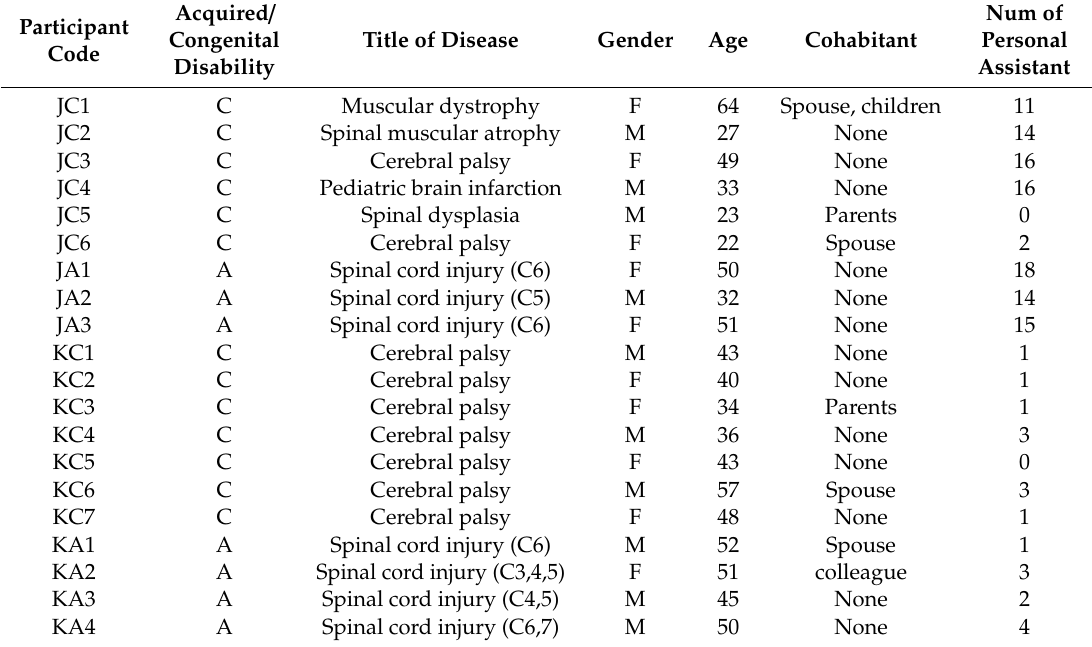
Table 1. Demographic and disability-related information of the